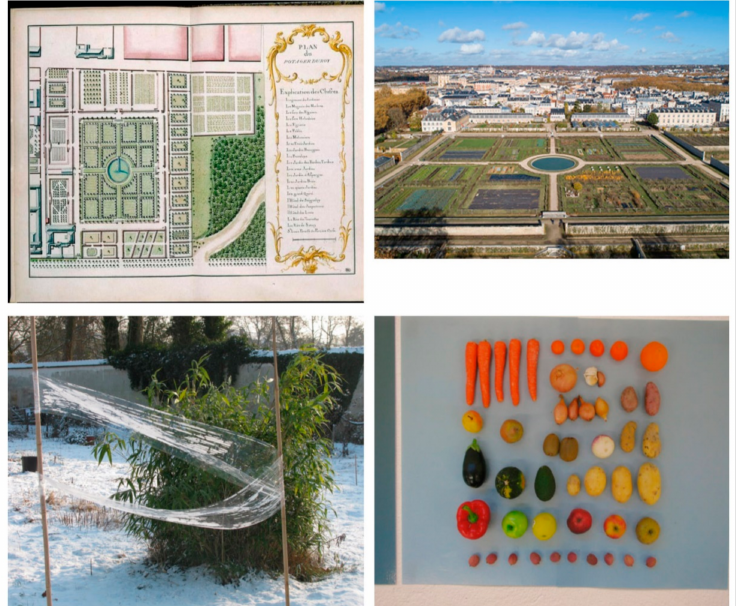
Figure 3. On top, plan and overview of the “Potager du Roi” at the É cole Nationale Sup é rieure de Paysage (ENSP) in Versailles. Below two examples of student work in the visual research studio “La Peau”; on the left in the outside, on the right in the studio